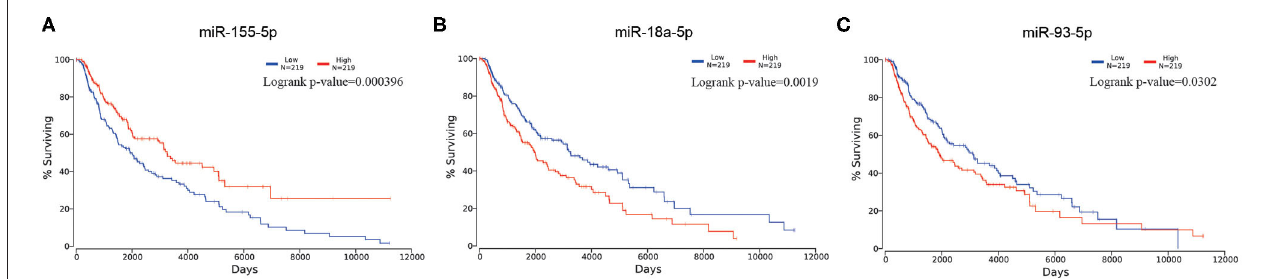
FIGURE 1 | Kaplan–Meier survival curve of selected miRNA in melanoma. (A) for miR-155-5p; (B) for miR-18a-5p; (C) for miR-93-5p.